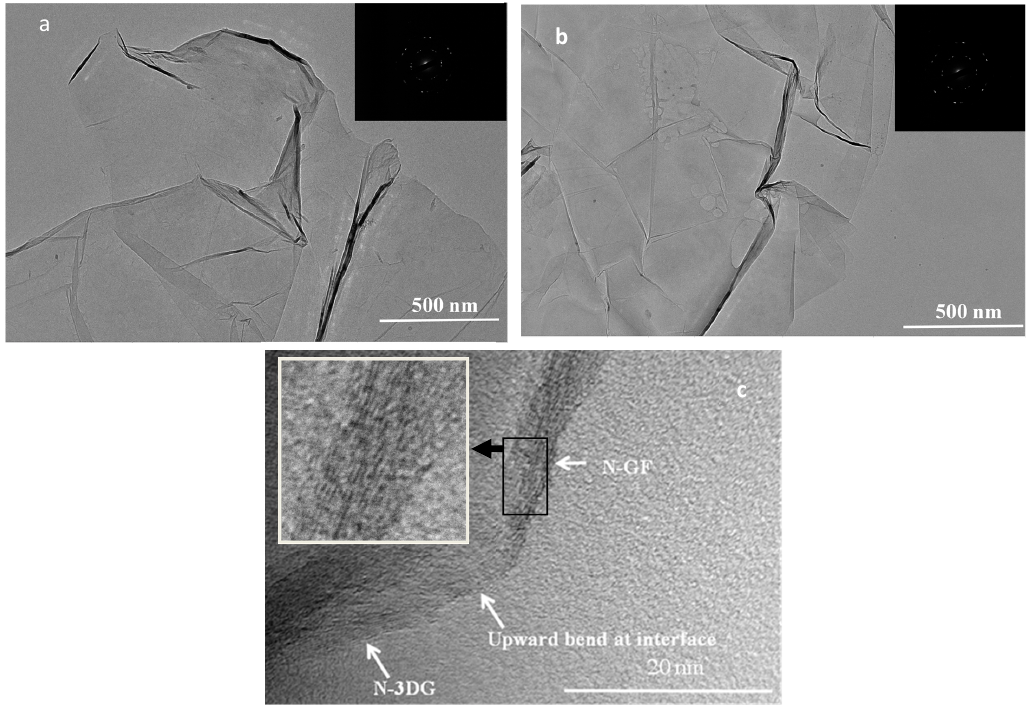
Figure 6. ( a ) TEM image of sample H2 (inset di ff raction pattern), ( b ) TEM image of sample H3 (inset di ff raction pattern), ( c ) HRTEM image of H2 showing interface of N-3DG and N-GF.